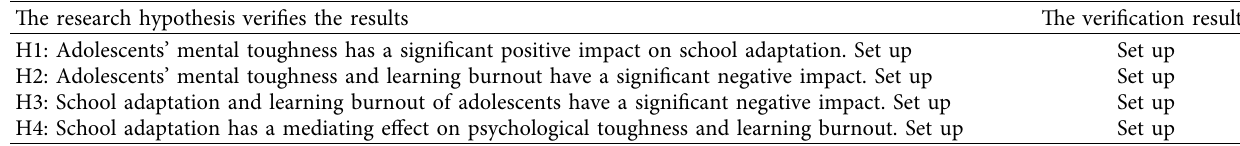
Table 11: Summary of research